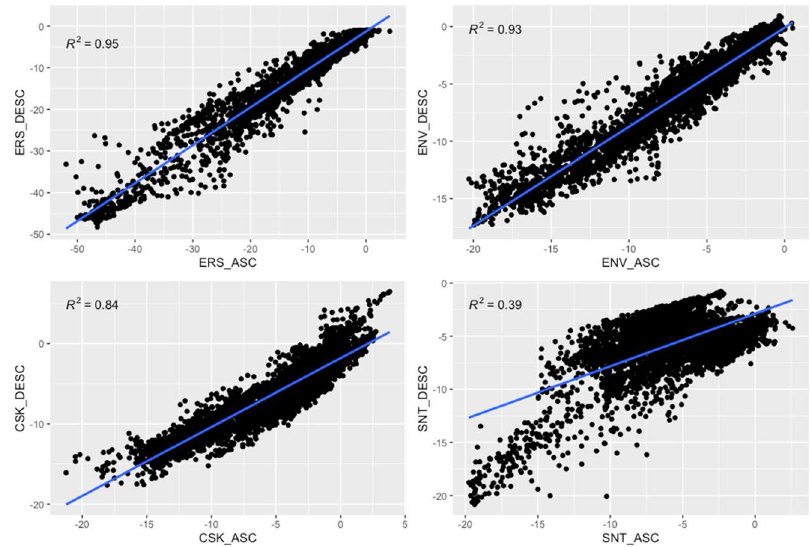
Figure 4. For each satellite, the ground velocities in the subsiding area are compared by plotting the common ascending and descending pixel values in the horizontal and vertical axes, respectively. The values are expressed in mm/yr. Black points are the velocities of the whole subsiding study area. The blue line is the linear interpolation, and the R2 values are reported. The ground velocities for ERS, ENV and CSK are comparable for both ascending and descending orbits with R2 close to 1, while the SNT velocities show values more dispersed (with a much lower R2) than in the previous periods. Table 4. The ground velocities and vertical ground displacements in three selected areas (CAN, CER and TDA), measured by four satellites (ERS, ENV, CSK and SNT).